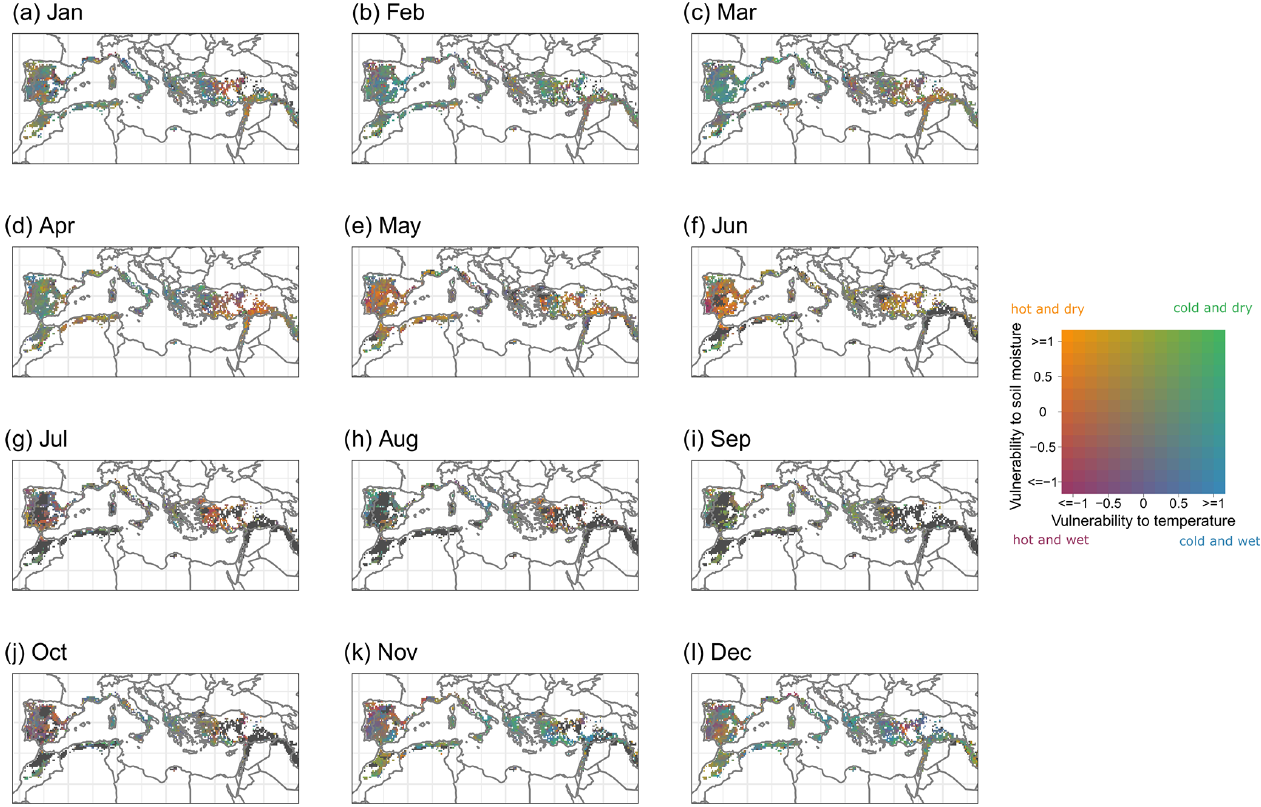
Figure B1. Average monthly vulnerability to soil moisture (ESA CCI) and temperature (ERA5-Land) in the Mediterranean Basin for (a) Jan- uary, (b) February, (c) March, (d) April, (e) May, (f) June, (g) July, (h) August, (i) September, (j) October, (k) November and (l) December. Grid points without any events during the respective month are displayed in